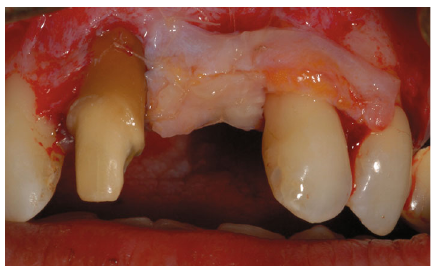
Figure 9: Sutured multilayered connective tissue graft (frontal view).